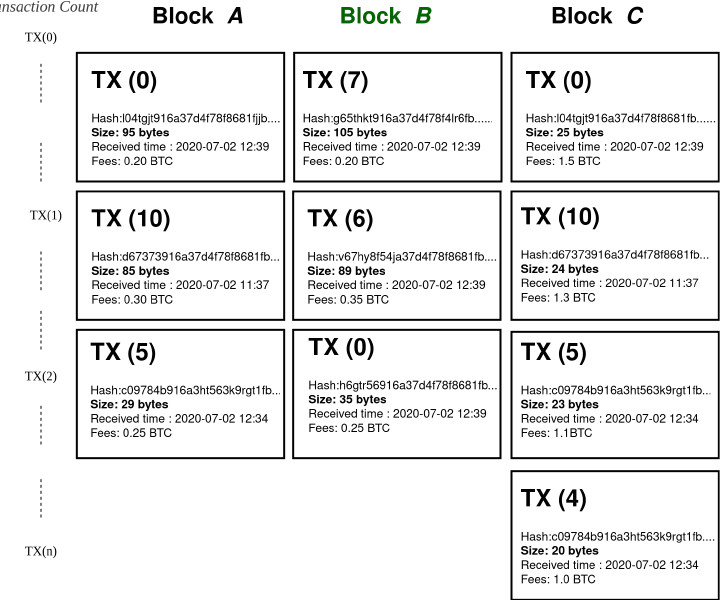
Figure 8. An example where 3 blocks are compared. Block B wins over A and C for having large-sized